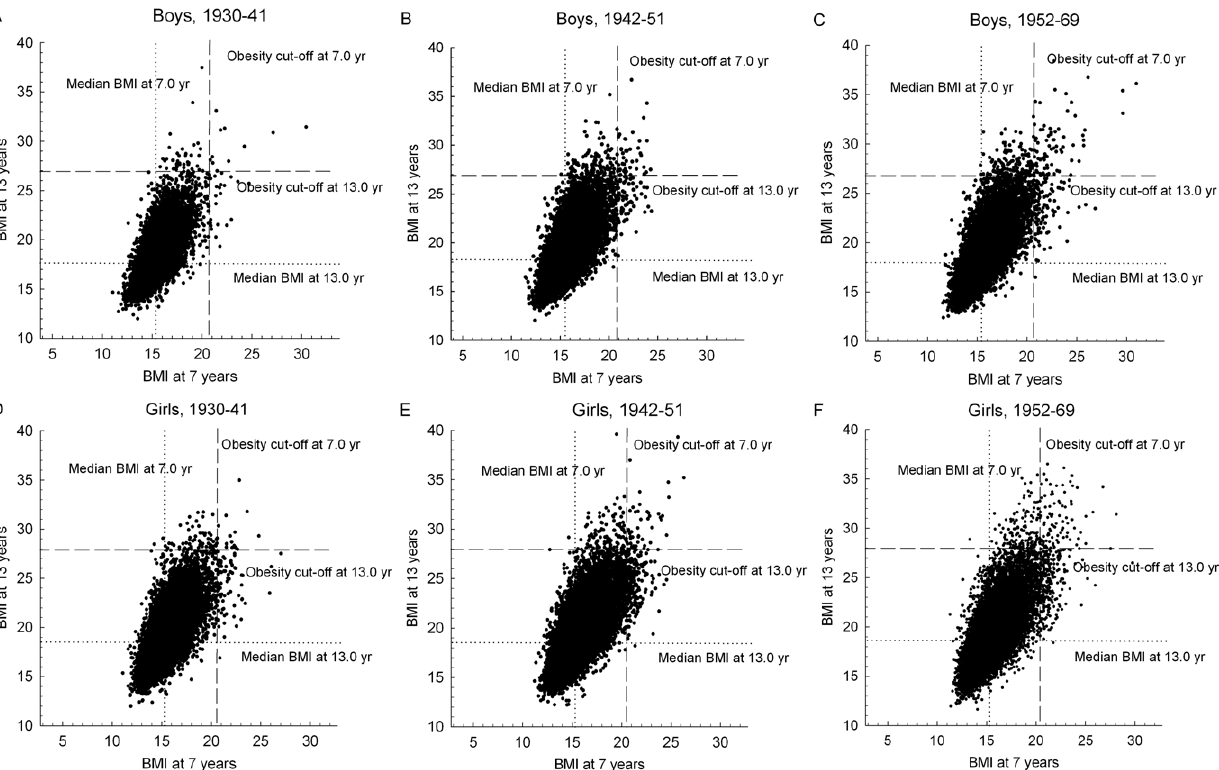
Figure 1. Correlation between BMI at 7 years and BMI at 13 years. The figure shows the correlation between BMI at 7 years and BMI at 13 years in each birth cohort among 96 848 boys (upper panels) and 96 106 girls (lower panels) in the Copenhagen School Health Records Register. Children with a BMI at age 7 years , 10.5 (n=38) were not included. Obesity was defined by International Obesity Task Force criteria. The dotted vertical and horizontal lines represent the cut-offs for obesity at 7.0 and 13.0 years respectively. For children aged 90 to 95 months and 162 to 167 months the cut-offs for 7.5 and 13.5 years respectively were used to define obesity. The four quadrates represent never-obese (lower left quadrant), incident obese (upper left quadrant), persistently obese children (upper right quadrant) and children who remitted from obesity (lower right quadrant) from 7 to 13 years of age.